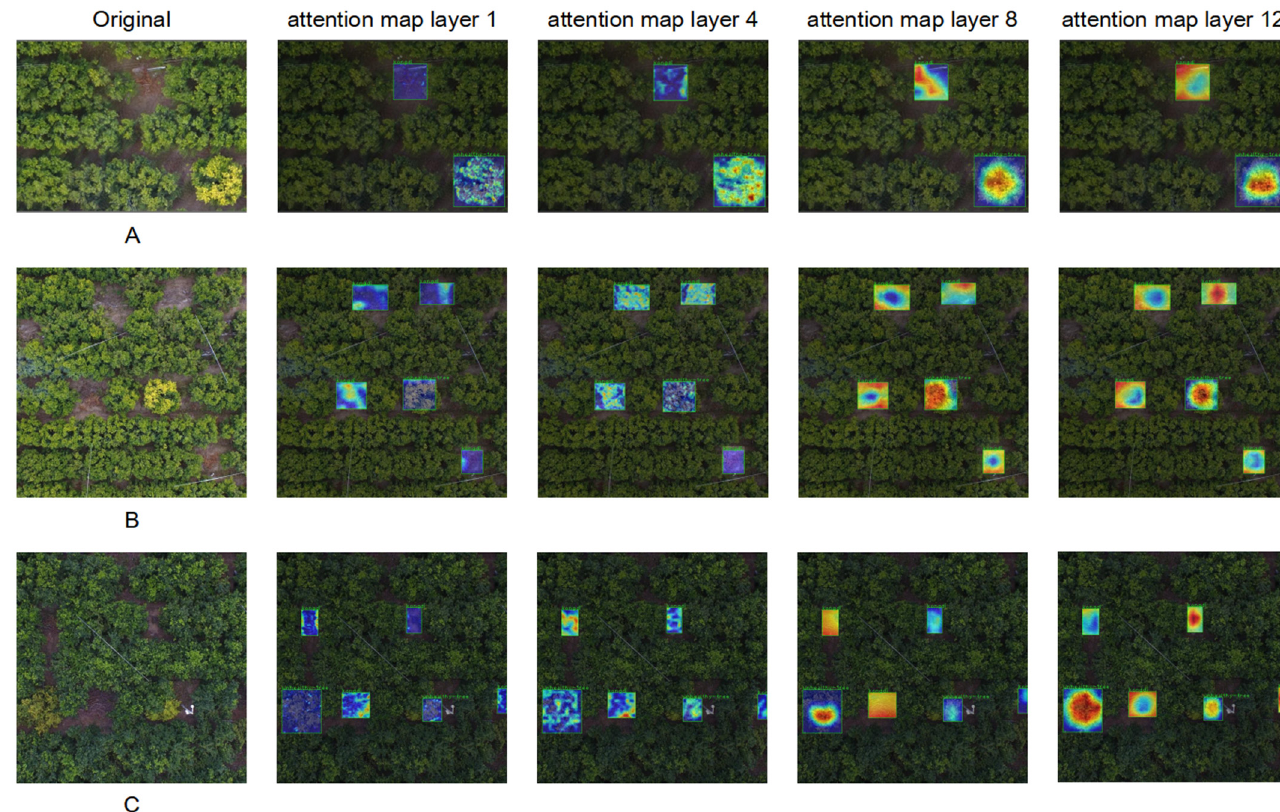
Figure 8. ( A – C ) Three groups of pictures show Attention maps for the 1st, 4th, 8th and 12th layers of the Swin Transformer. The three images in the first column are sample images.